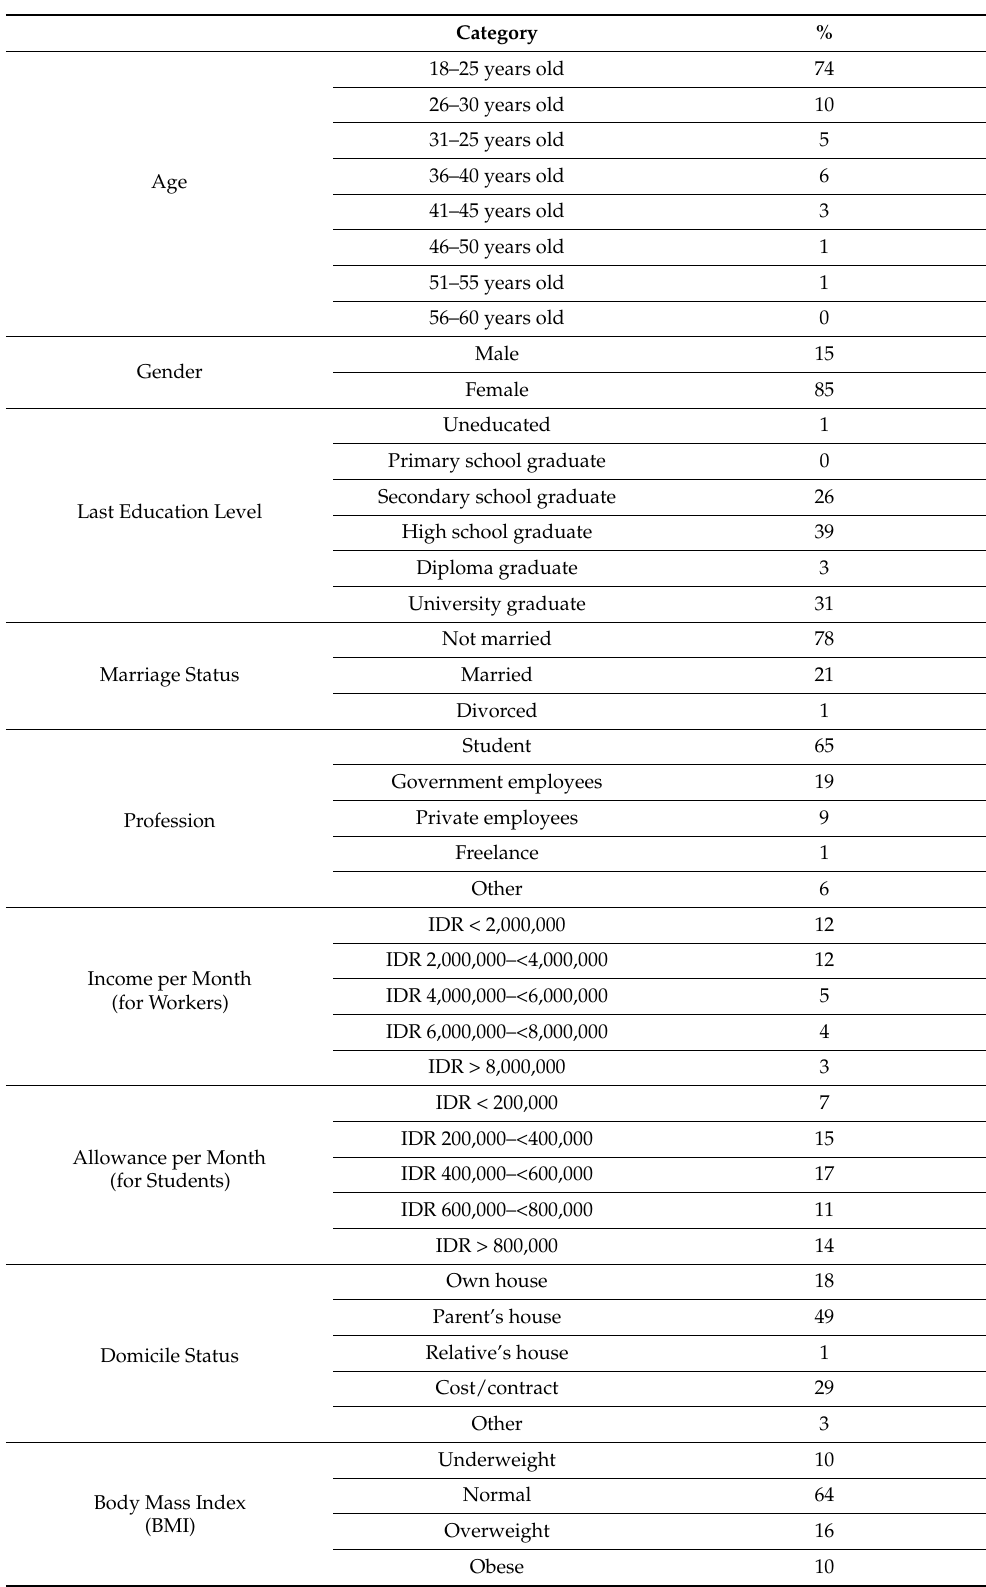
Table 1. Characteristics of the